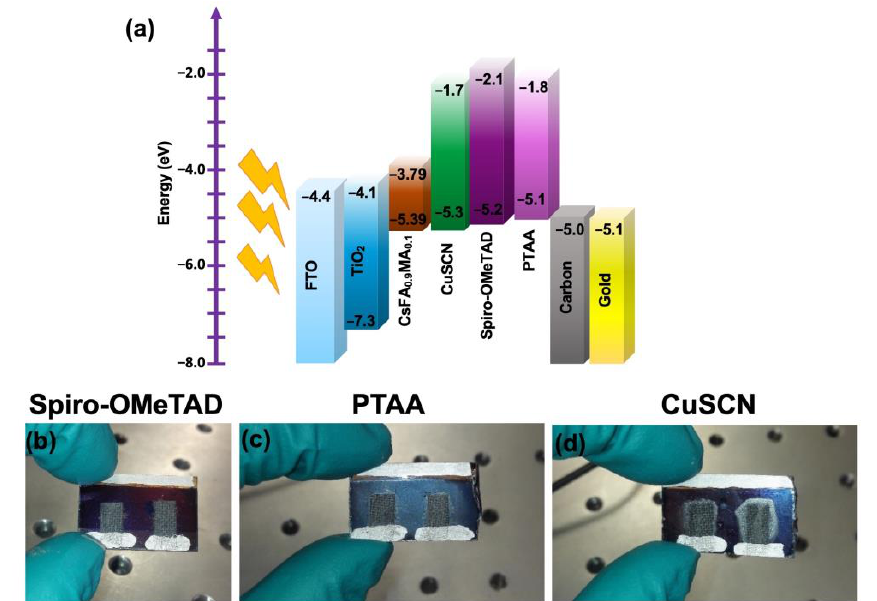
Figure 6. The corresponding energy band diagram for the carbon, or gold-based devices with three different HTMs ( a ). The optical images of the Spiro-OMeTAD/carbon ( b ), PTAA/carbon ( c ), and CuSCN/carbon-based devices ( d ).